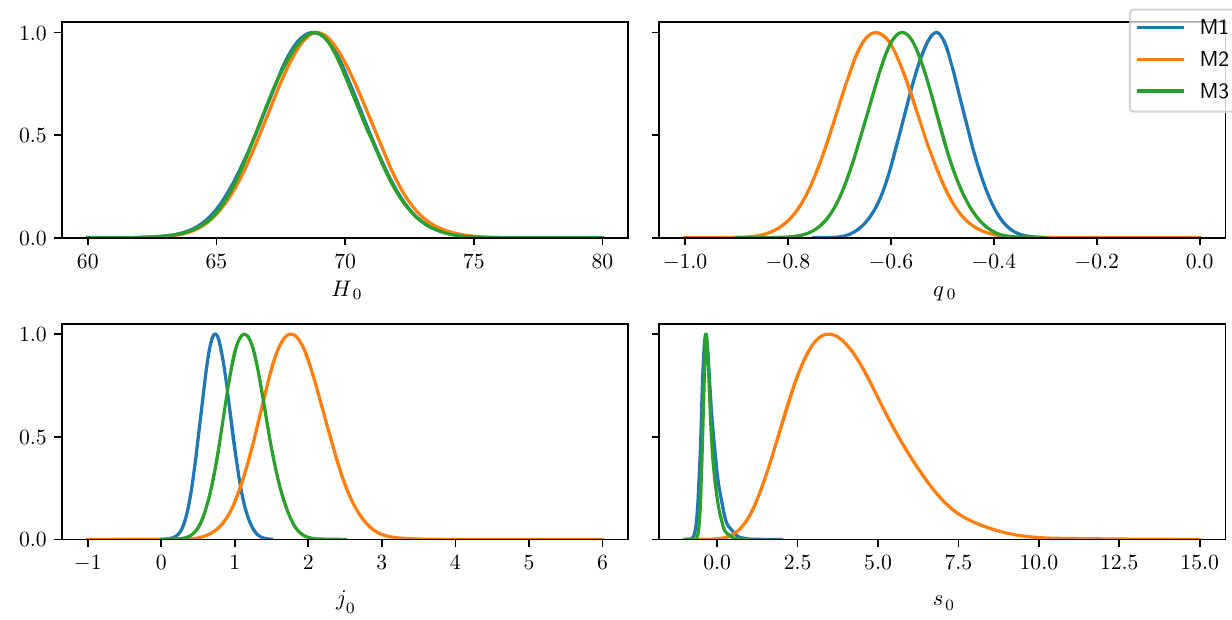
Fig. 7 Marginalized posteriors for models M1, M2 and M3